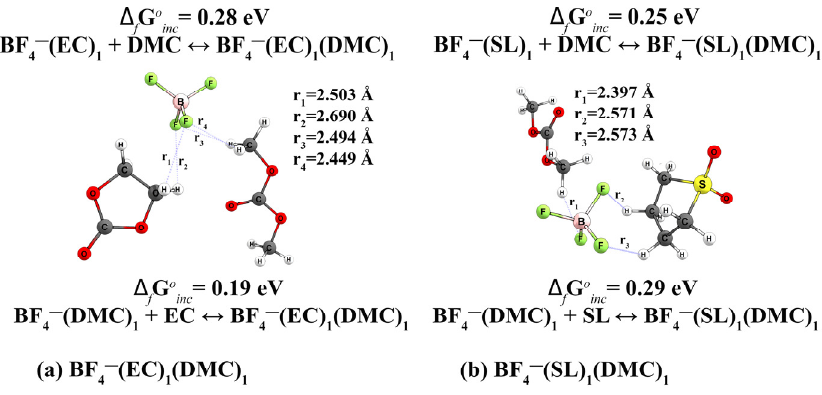
Figure 3. Geometric structures of anionic complexes BF 4 − with (EC) 1, (DMC) 1, ( a ) (SL) 1 and (DMC) 1 ( b